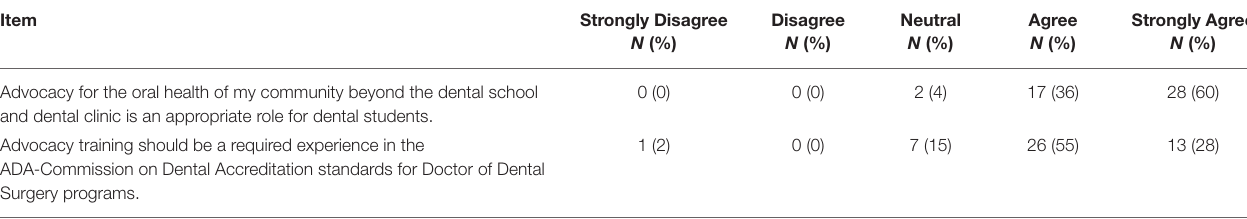
Disagree Neutral Agree Strongly Agree N (%) N (%) N (%) N (%) N (%) 0 (0)